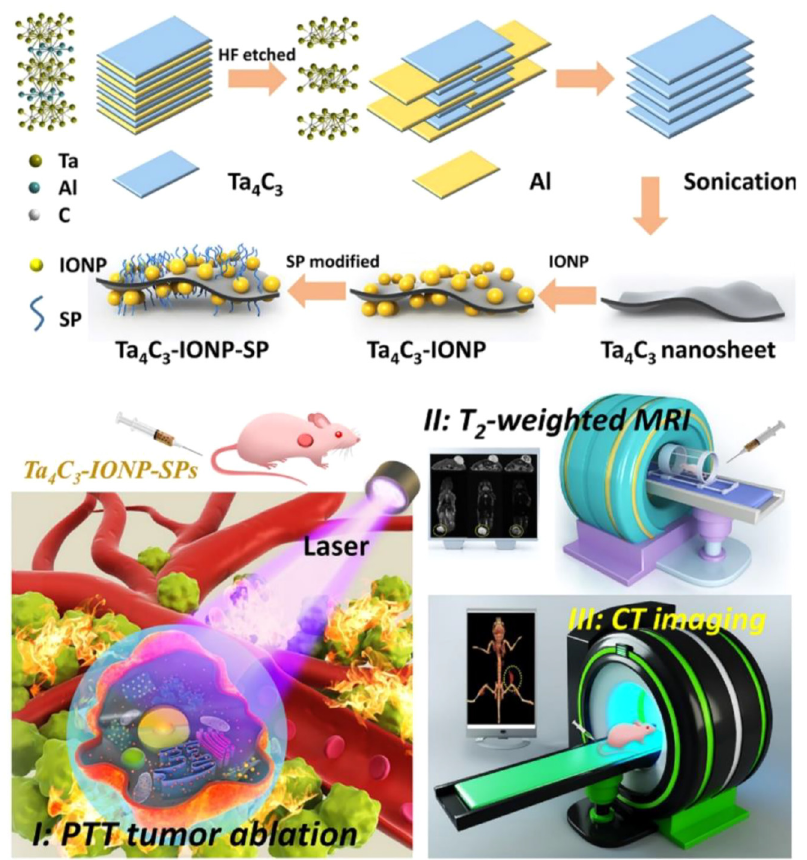
C -IONP-SPs nanosheet and MRI/CT dual-modality imaging-guided tumor 4 3